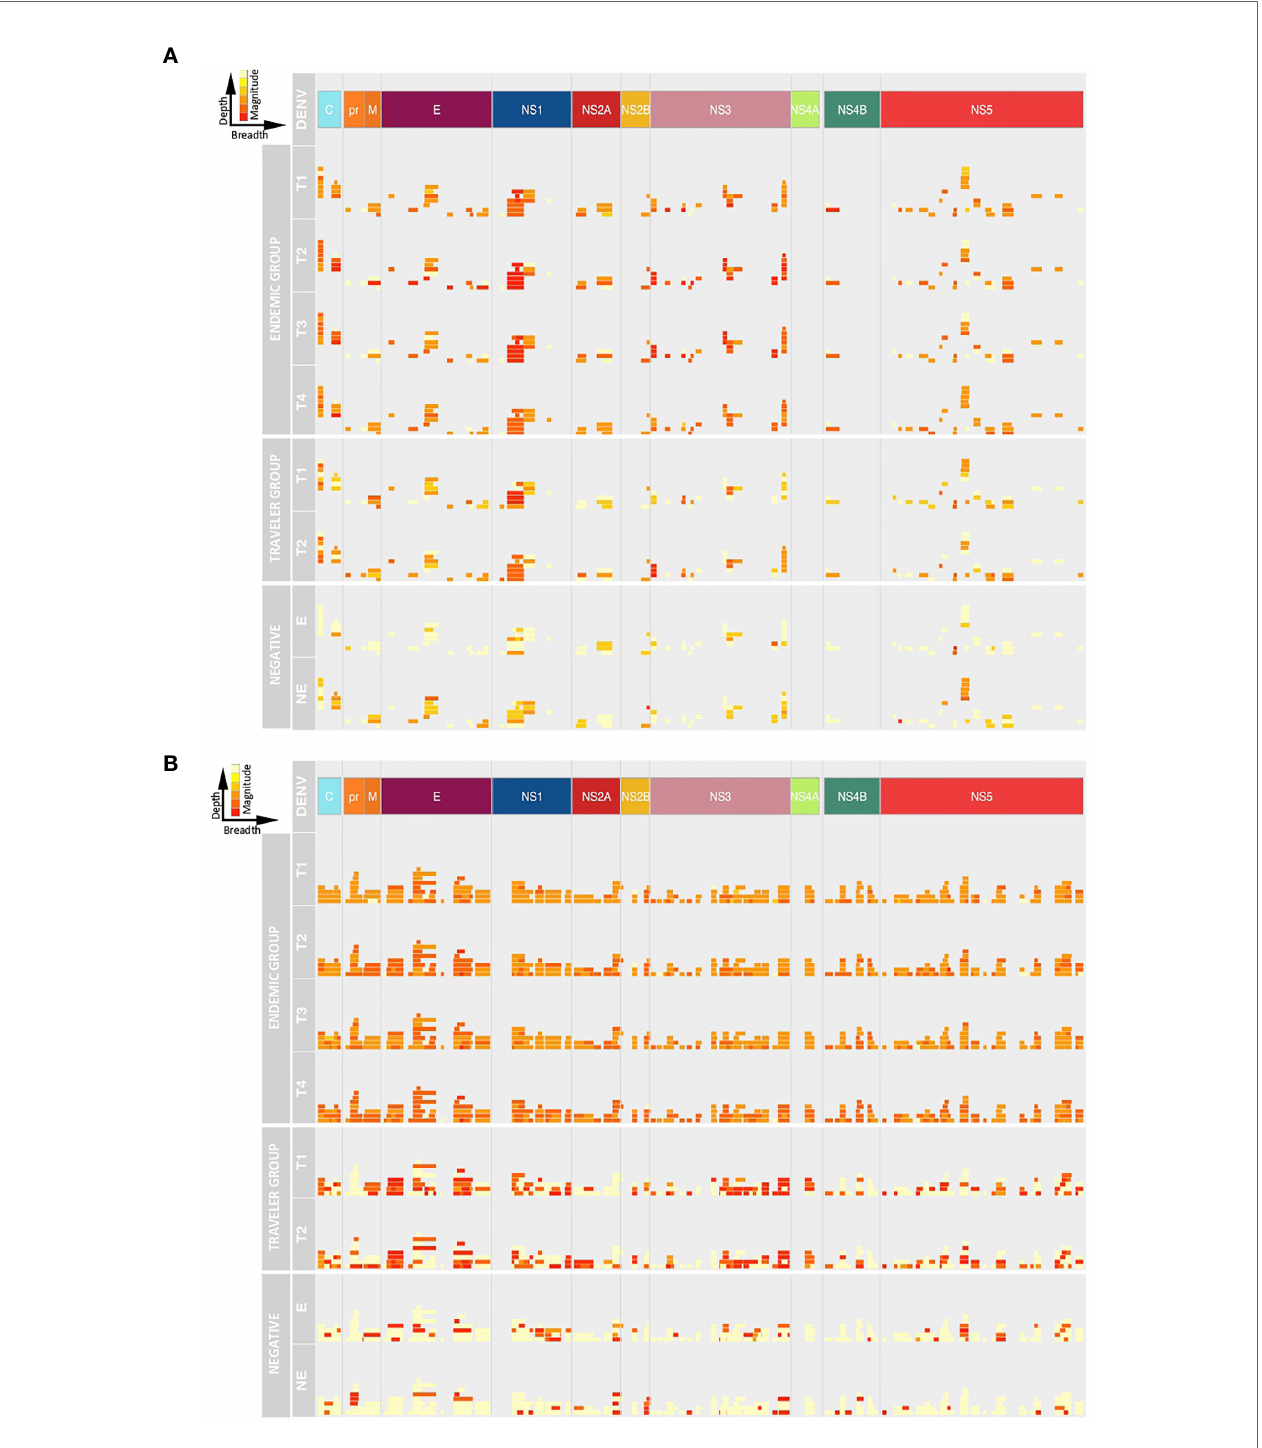
FIGURE 4 | Depth and breadth of the humoral response against DENV peptides. The plots show the Ab target regions (ATRs) for IgG (A) and IgM (B) aligned to the proteomic coordinates for DENV (Uniprot ref: P33478). Structural: Capsid (C), Membrane (pr, M) and Envelope (E), and non-structural proteins: NS1, NS2A, NS2B, NS3, NS4A, NS4B and NS5 are color represented. Each bar in the plot represents an ATR. The depth (different epitope variants recognized by the sera) of the Ab response is read vertically, the breadth (binding sites across the polyprotein) of the Ab response is read horizontally and the color intensity of each ATR indicates the magnitude of the Ab response, in terms of arbitrary fl uorescence intensity units after Log2 transformation (ranging from 0 to 16). T1: acute, T2: early convalescent, T3: mid convalescent and T4: late convalescent samples. E: endemic and NE: non-endemic negative